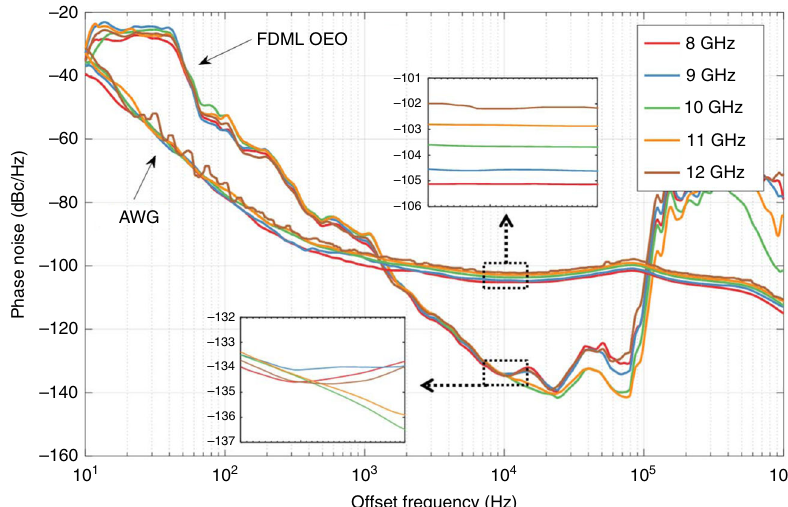
Fig. 7 Measured phase noise performance. Phase noise of microwave signals in X-band generated by the FDML OEO and a state-of-art electronic arbitrary waveform generator (AWG) are measured. Inset shows the detailed phase noises at 10 kHz frequency offset. AWG arbitrary waveform generator